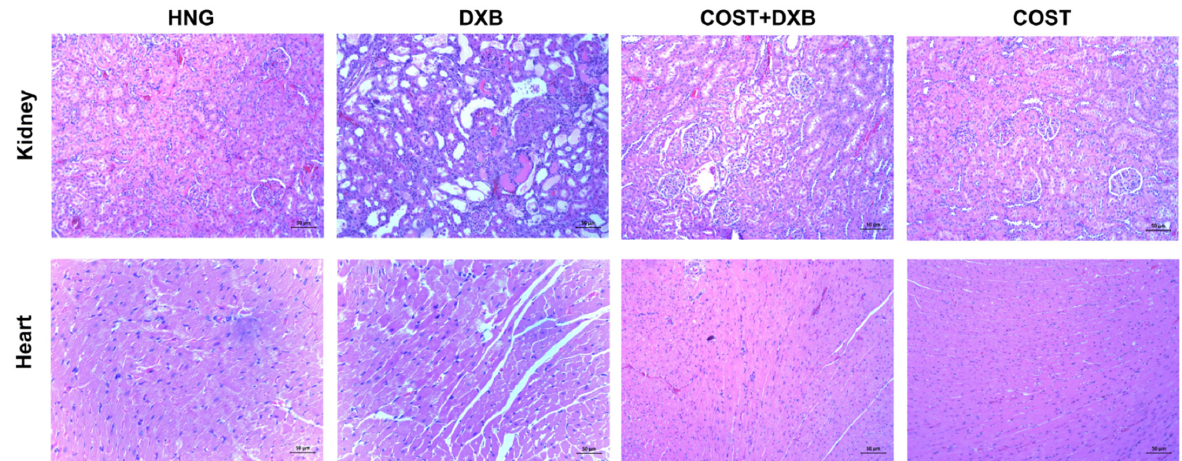
Figure 5. H&E stained photomicrography of the kidney and cardiac tissues from all tested groups. Kidney: red arrows; glomerular atrophy, black arrow; infiltration of inflammatory cells, green arrow; disintegration of renal tubules. Heart: blue arrow; inflammatory cells, brown arrows; degeneration of myofibrils (200×, 50 µm).